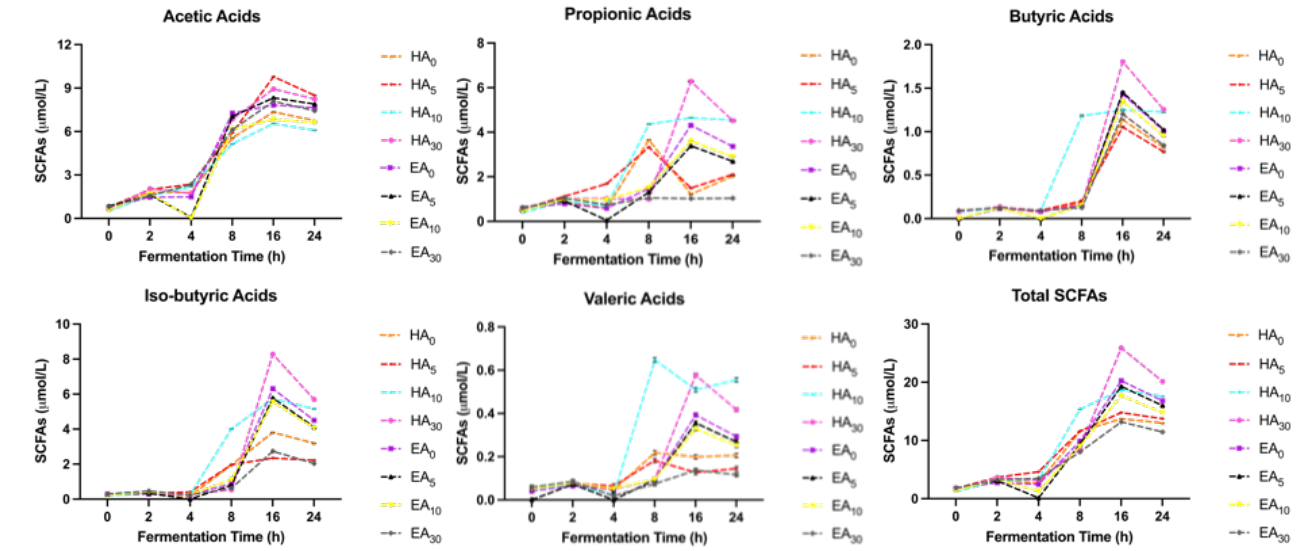
Figure 3. The production of five types of short chain fatty acids, including acetic, propionic, butyric, iso-butyric and valeric acids in FBH (HA 0 , HA 5 , HA 10 , & HA 30 ), and FBE (EA 0 , EA 5 , EA 10 , & EA 30 ) fermented with six-time variables (0 h, 2 h, 4 h, 8 h, 16 h, & 24 h).